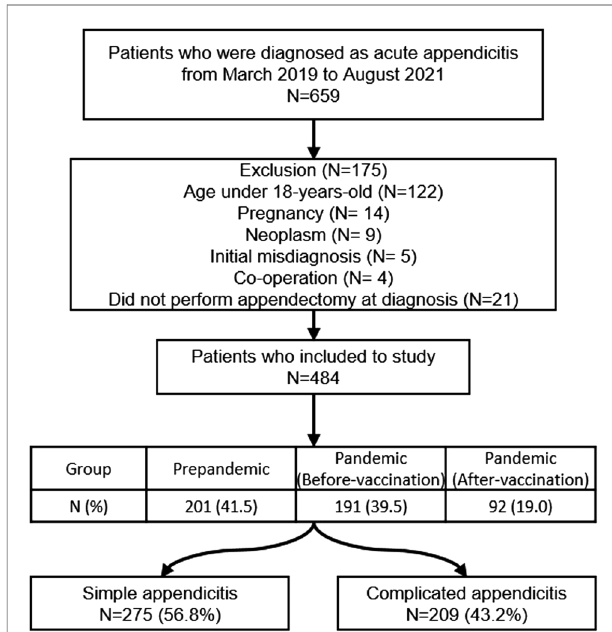
FIGURE 1 | Patients included in the